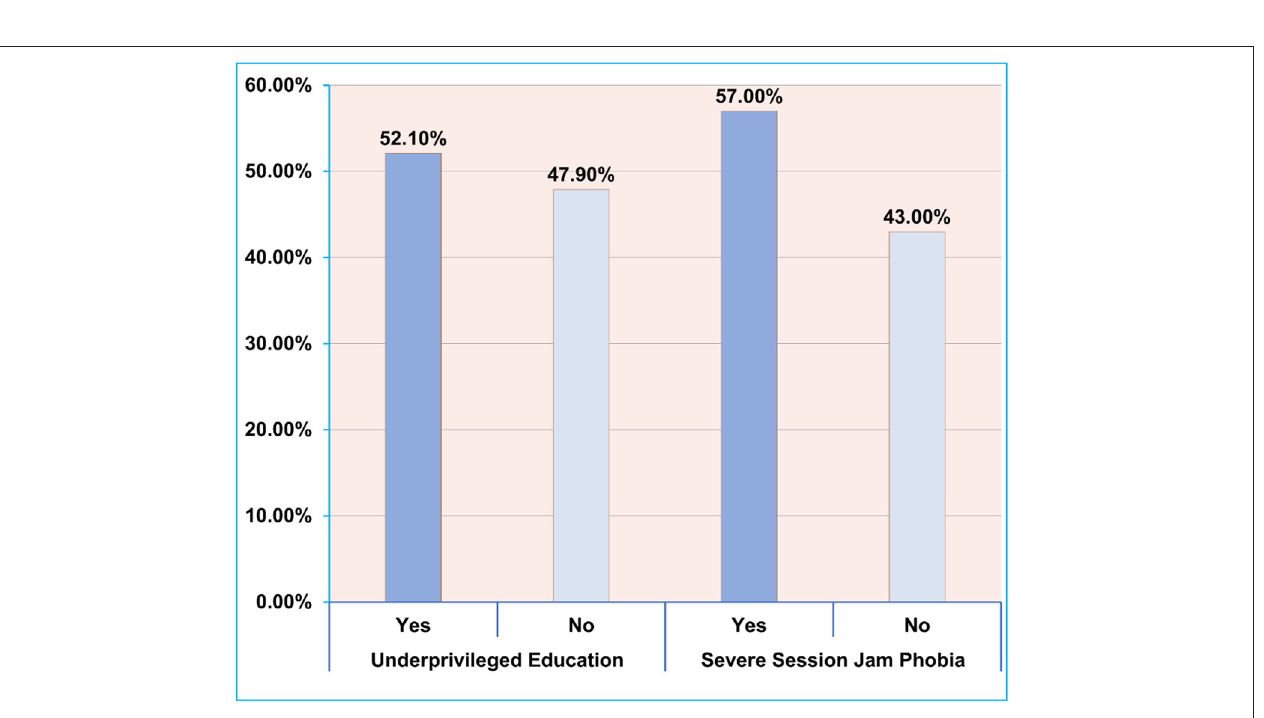
Frontiers in Public Health |